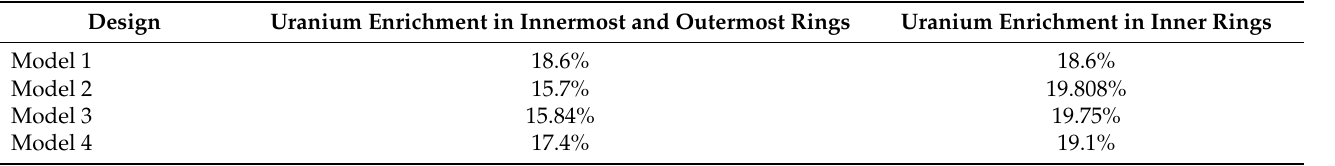
Figure 2. Power − flattening design of KLT − 40S fuel assembly. Figure 2. Power-flattening design of KLT-40S fuel assembly. Table 4. Power-flattening designs. Table 4. Power − flattening designs.